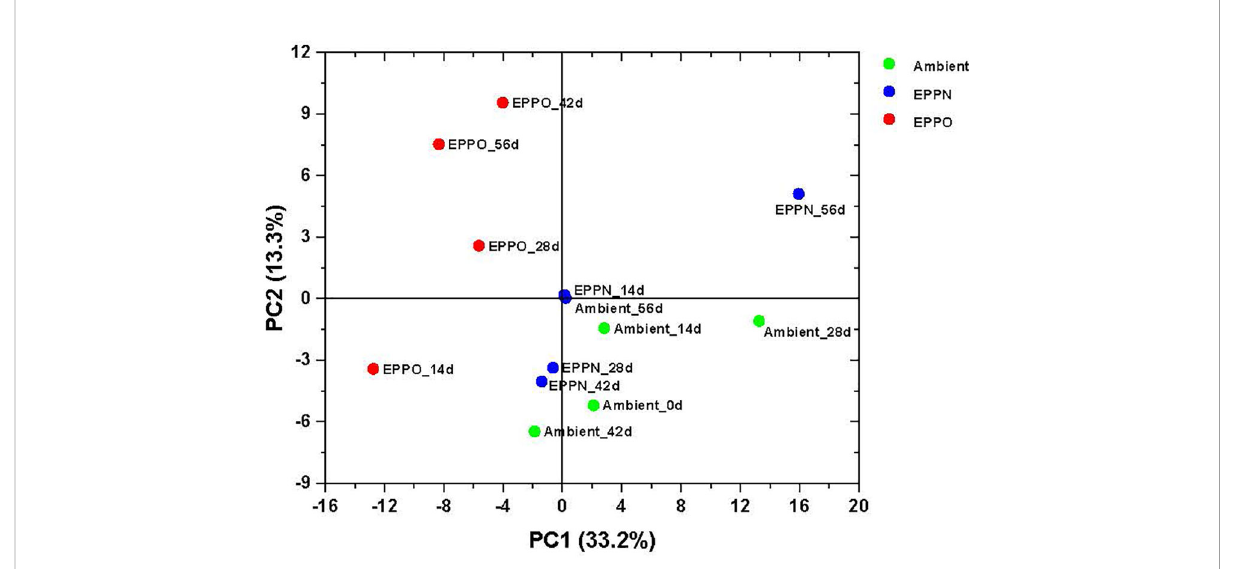
FIGURE 3 Headspace volatile analysis of rice seeds stored under EPPO and its control conditions. Principal component analysis based on the relative abundance of 183 volatile